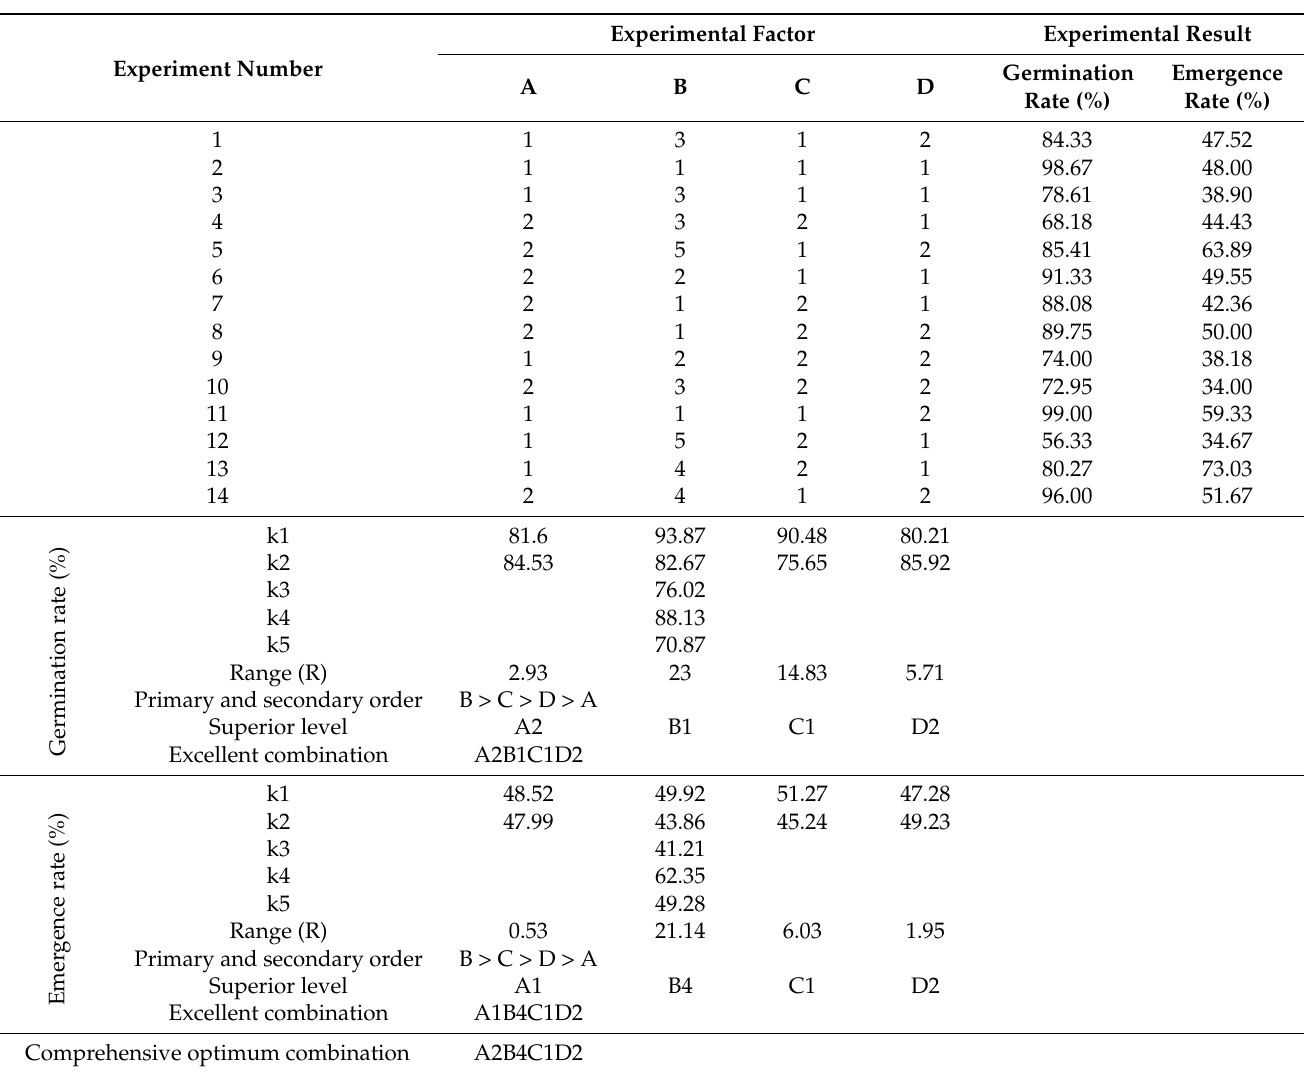
Table 1. Orthogonal experimental design and optimum results of Meili grape